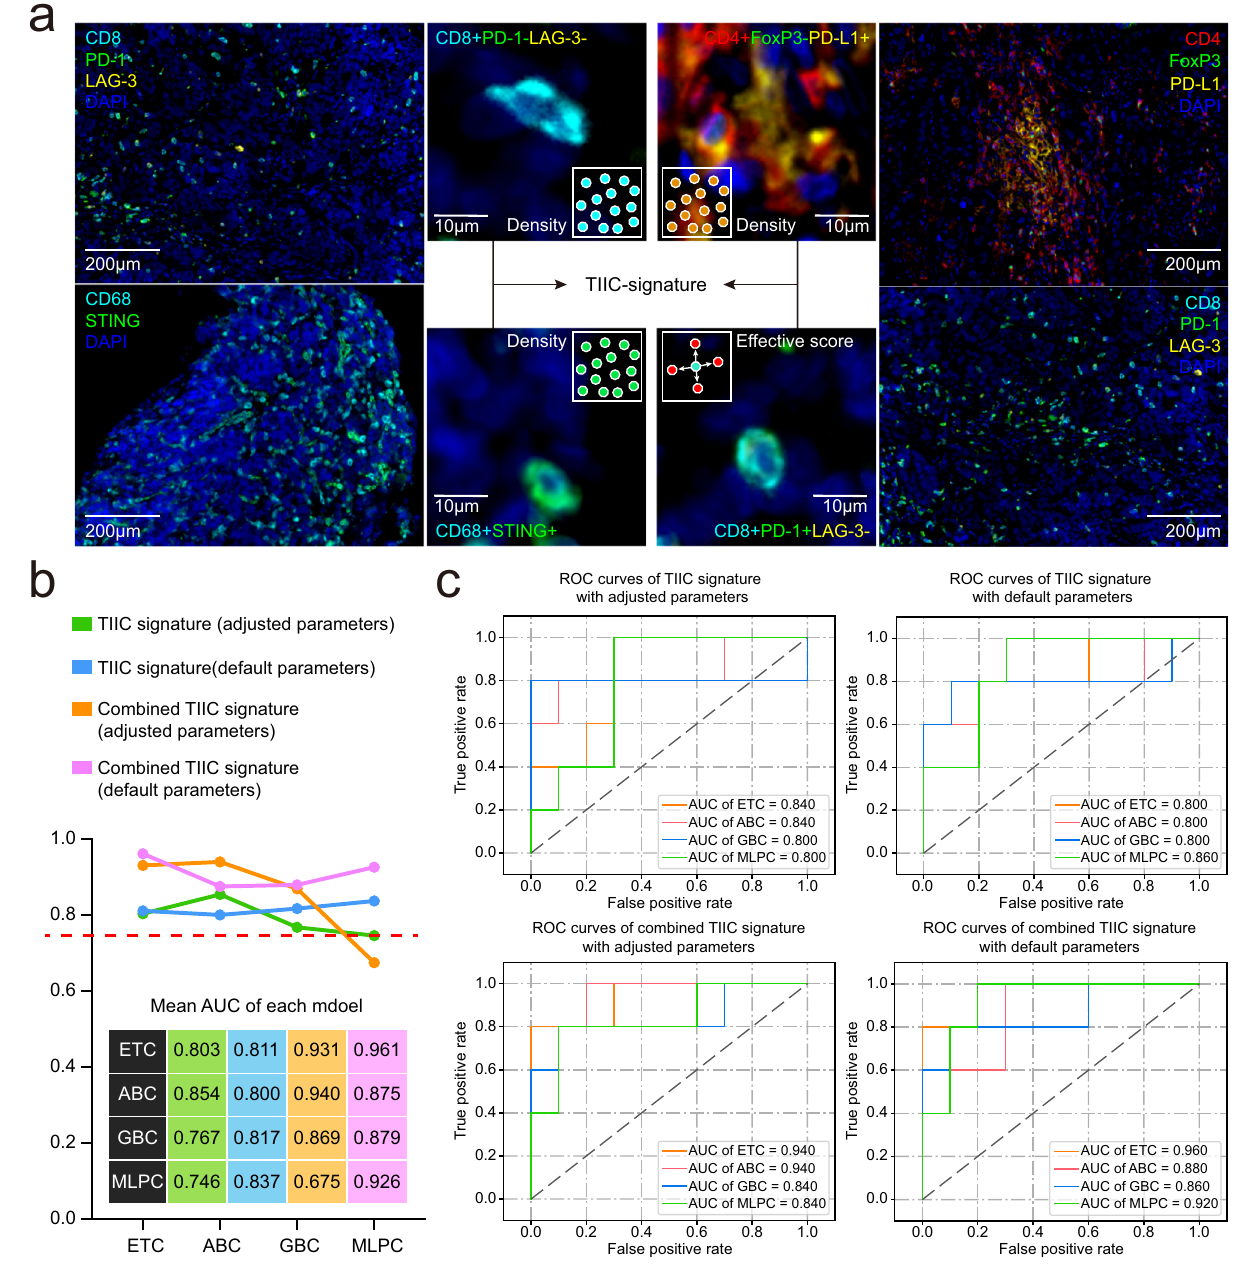
Fig. 4 | The TIIC signature predicts the response to anti-PD-1/PD-L1-based immunotherapy. a De fi nition of the tumour-in fi ltrating immune cell (TIIC) sig- nature.Redarrowshighlightspeci fi cimmunecells. b Averageareaunderthecurve (AUC) of TIIC signature and combined TIIC signature (TIIC+ Epstein – Barr virus status+mismatch repair status+PD-L1 combined positive score) in the four